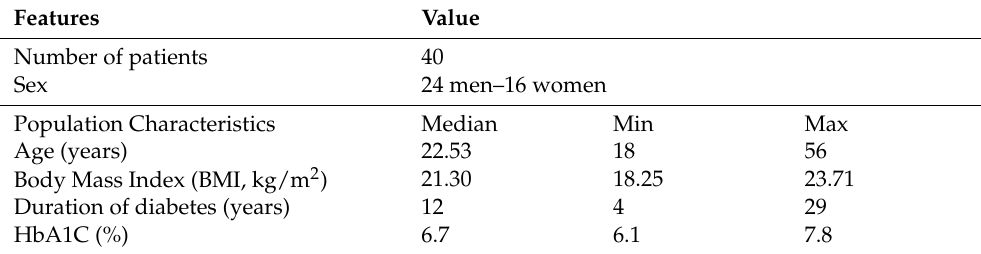
Table 2. Information on the DM1 patients included in the trial.